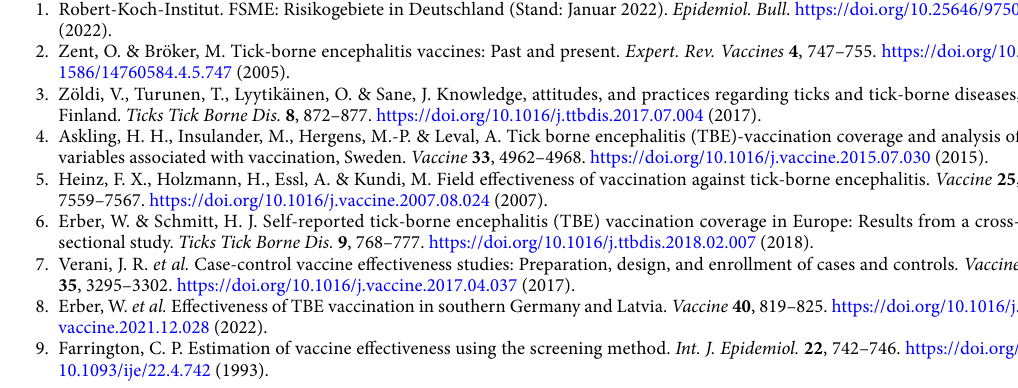
P-values < 0.05 were considered statistically significant. Data were analysed in Stata 17 ® . VE based on the case–control approach. Participants not living or spending time in risk areas were excluded (5 cases, 11 controls). Six cases who received their first dose after onset were excluded (see Supplementary Fig. 1). Directed acyclic graphs (DAGs) were constructed in Dagitty 36 to explore the underlying causal structure and identify minimal adjustment sets for estimating the total causal effect for vaccination on TBE (Supplementary Fig. 2). We calculated adjusted odds ratios with 95% confidence intervals (CI) using multivariable logistic regres- Table 1. VE based on the screening method. We applied the formula (as in Ref. 5 ):